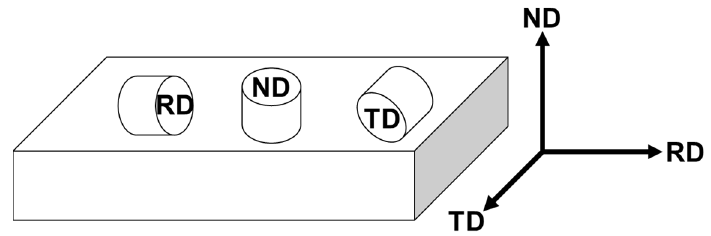
Figure 1. Schematic illustration of cylindrical specimens for quasi-static uniaxial compression test. They were machined along rolling direction (RD), normal direction ( ND), and transverse direction (TD),